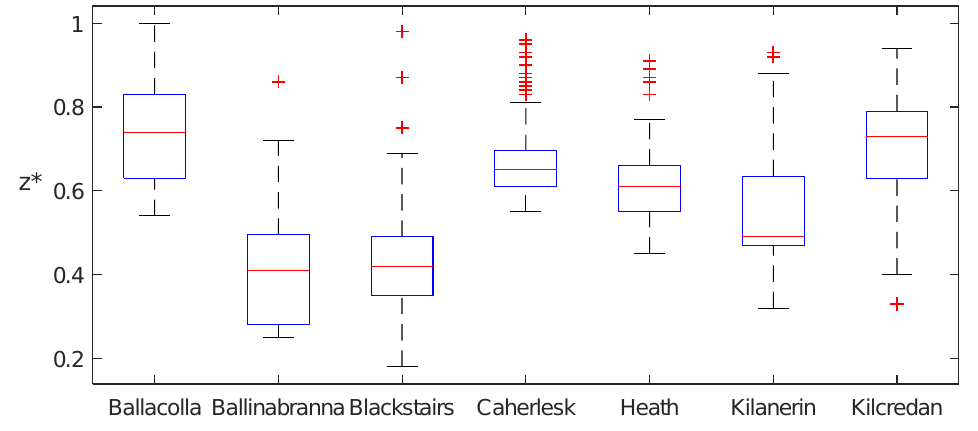
Figure 2. z* node coordinate for each